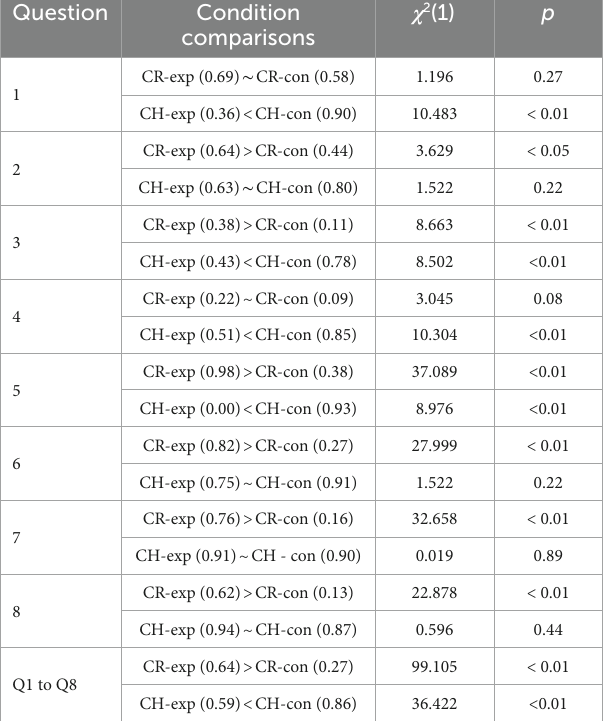
TABLE 2 Results involving proportion of correct responses and reliance on correlation heuristic among participants across different questions and conditions in task